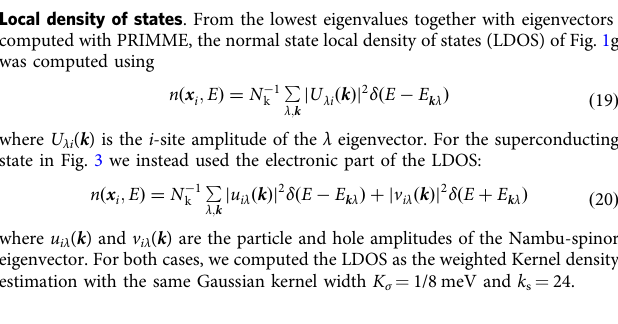
Table 1 Irreducible representation decomposition. Irrep